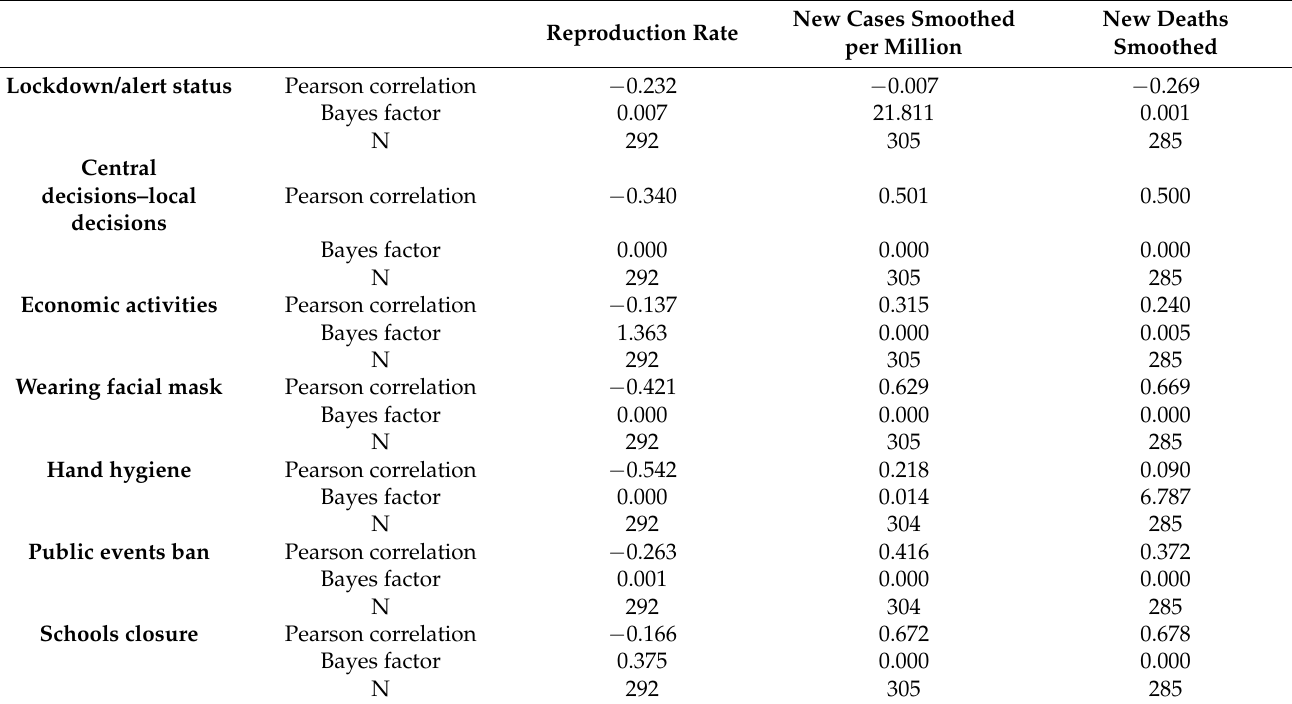
Table 1. Statistical analysis of the data series regarding the measures to increase the response capacity through the Pearson correlation and the Bayesian method. New Cases